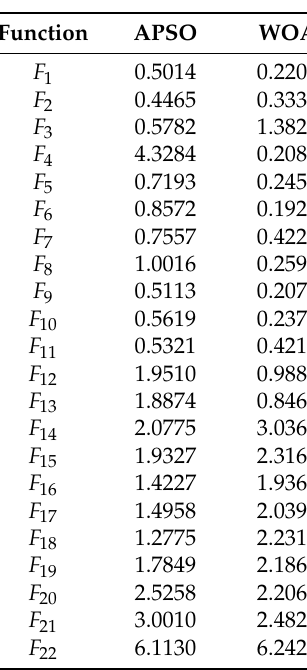
Table 10. The execution time of each algorithm.